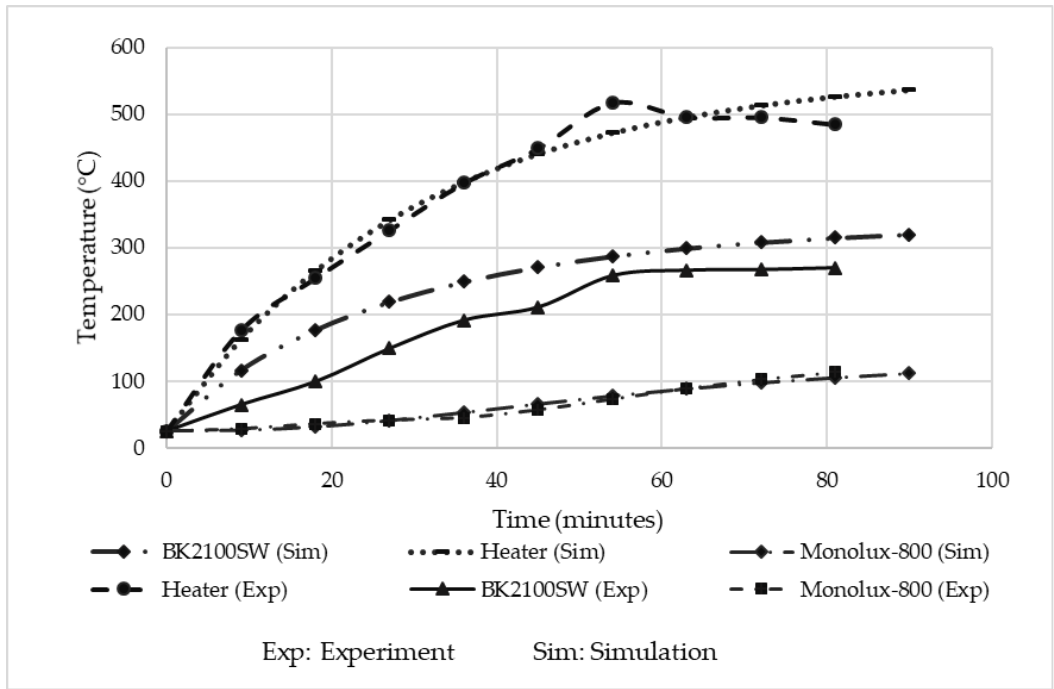
Figure 22. Comparison of simulated and experimental results for the current insulation material.